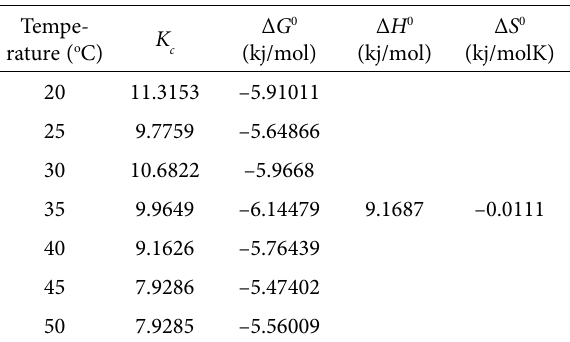
Table 3. K , Δ G 0 , Δ H 0 and Δ S 0 values of Cu 2+ ions at different c temperatures Tempe-